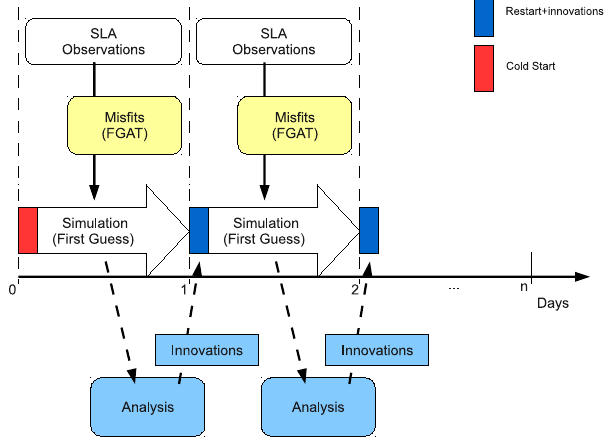
Fig. 1. Daily analyses cycle scheme. FGAT is the First Guess at Appropriate Time method for misfits calculation.